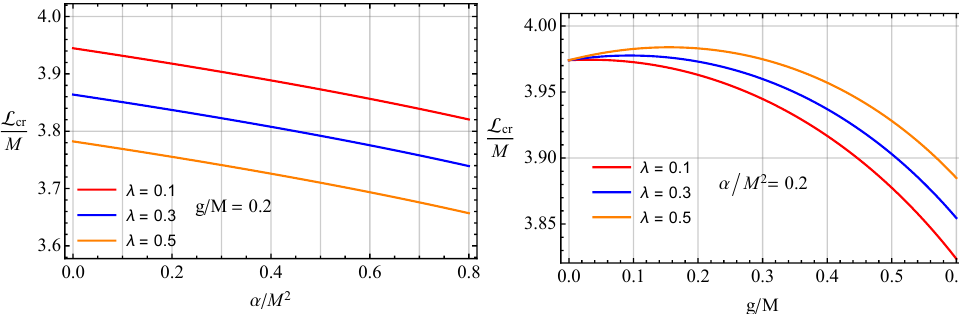
Figure 13. The same figure with Figure 11 but for magnetically charged particles.